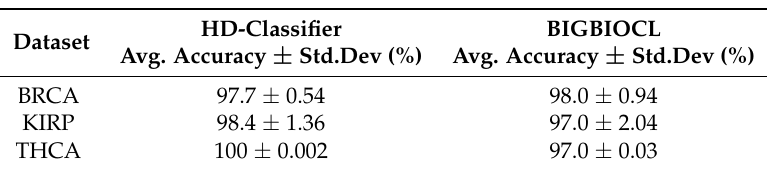
Table 6. Comparison of HD-classifier vs. BIGBIOCL classifier on ten different randomly generated training (80%) and test (20%) sets for each tumor dataset.